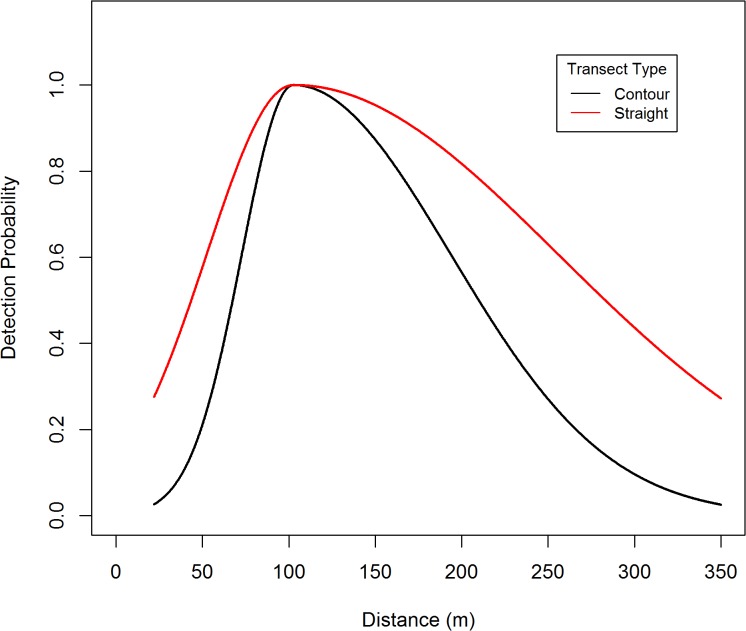
The effect of transect type on average covariate detection of black bears in the Skwetna study area of South-Central Alaska.